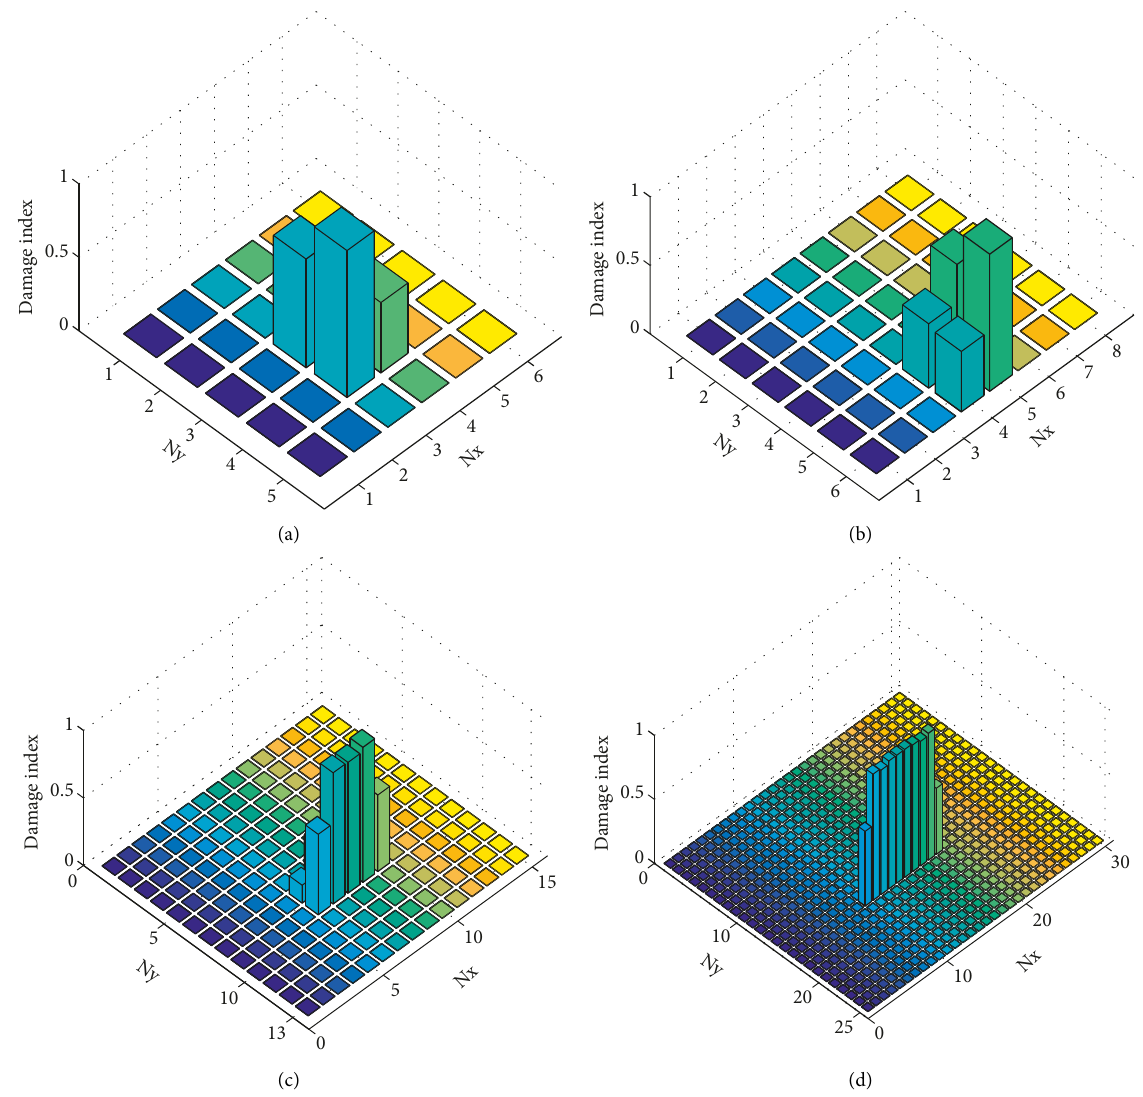
Figure 17: Truncated damage index charts of the second preliminary damaged area using damage threshold 40% Z max (b) Mesh 4%, (c) Mesh 2%, and (d) Mesh 1%.